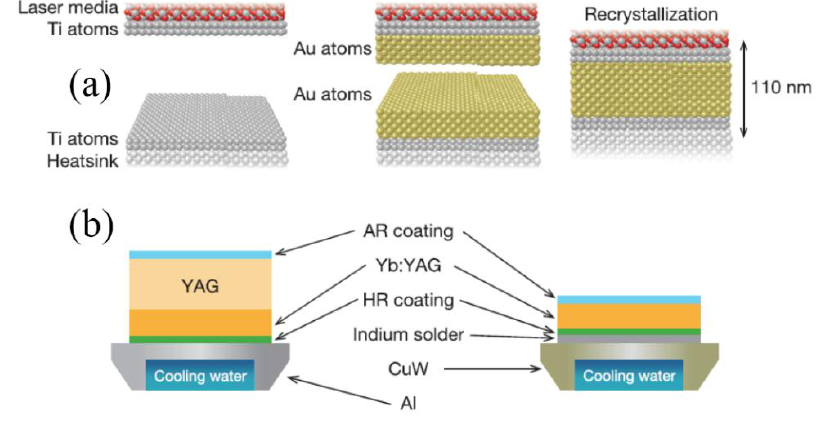
Figure 3. Process of Atomic Difusion Bonding (ADB): ( a ) Thin nanocrystalline Au films are deposited on the precisely polished and coated Yb:YAG and the Al heatsink surfaces at room temperature by the vacuum sputtering process. The bonding is accomplished in air by contacting the two Au surfaces and pressing. Recrystallization occurs at the Au–Au contact interface and the two surfaces can be bonded together without the use of adhesives or heat; ( b ) Schematic diagram of Yb:YAG/YAG composite ceramic thin disk on the Al heatsink fixed by the ADB technique ( left ) and commercially available Yb:YAG thin disk on the CuW heatsink fixed by soldering ( right ) [36].